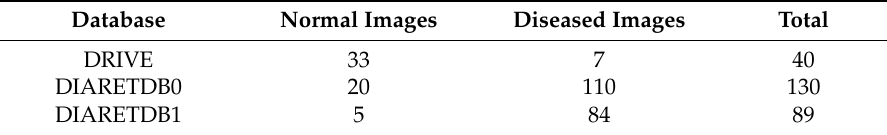
Table 1. The specifications of the public datasets used in this